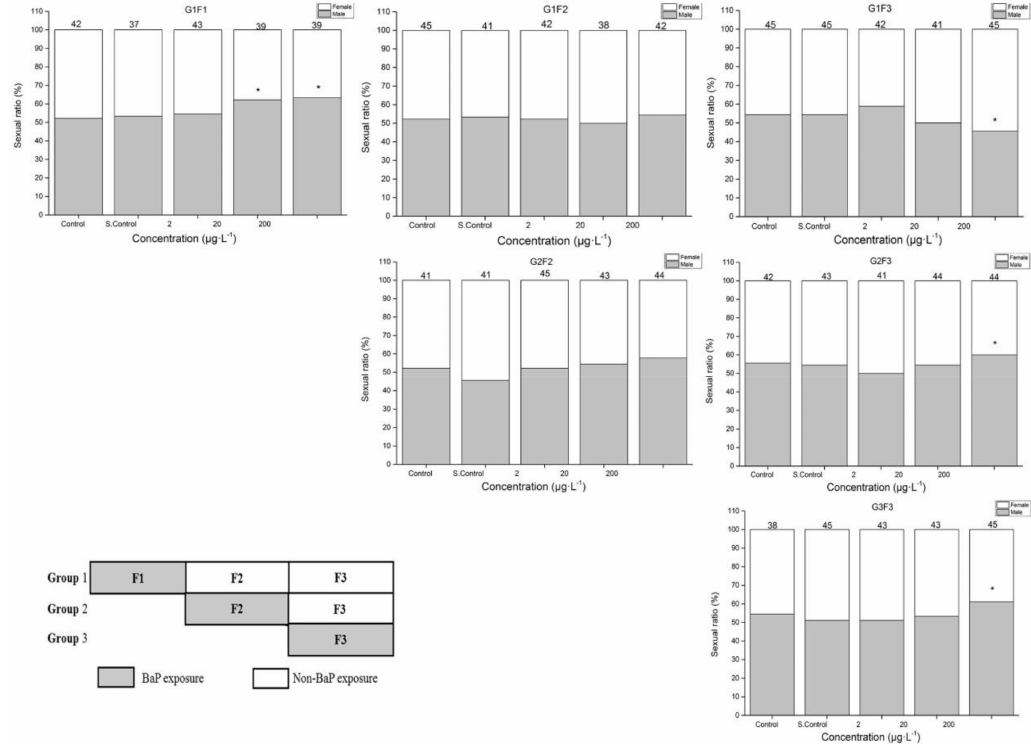
Figure 2. Data are expressed as the percentage of males and females in each group. A significant di ff erence in sex ratio from control: * p <